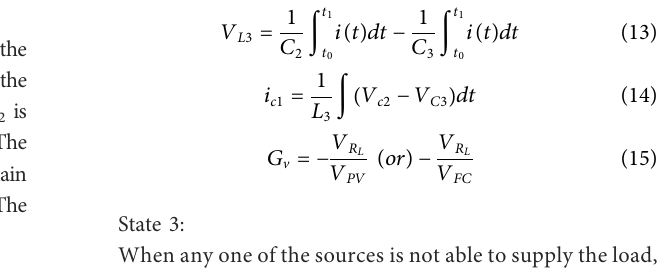
State 3: When any one of the sources is not able to supply the load, it is necessary to use two sources simultaneously. In mode 1, both switches (S 1 , S 2 ) are turned on and both inductors (L 1 ,